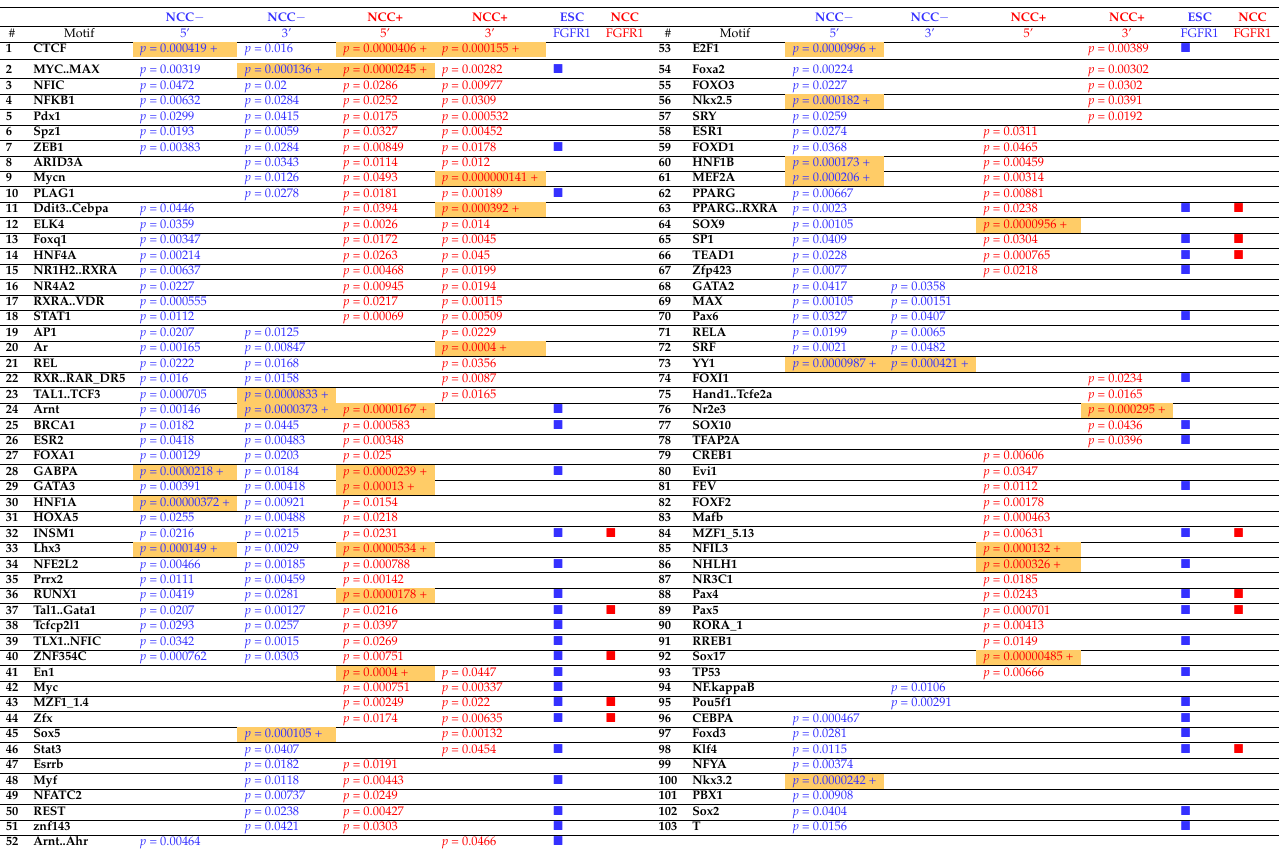
Table 1. Regulated TADs are under control of distinct transcription factors and architectural proteins during ESC to NCC differentiation. +/ − 35 kb border enrichment of protein binding motifs and +/ − 100 kb enrichment of nFGFR1 border motif targeting. Paired T -Test, Bonferroni adjusted p < 0.05 highlighted